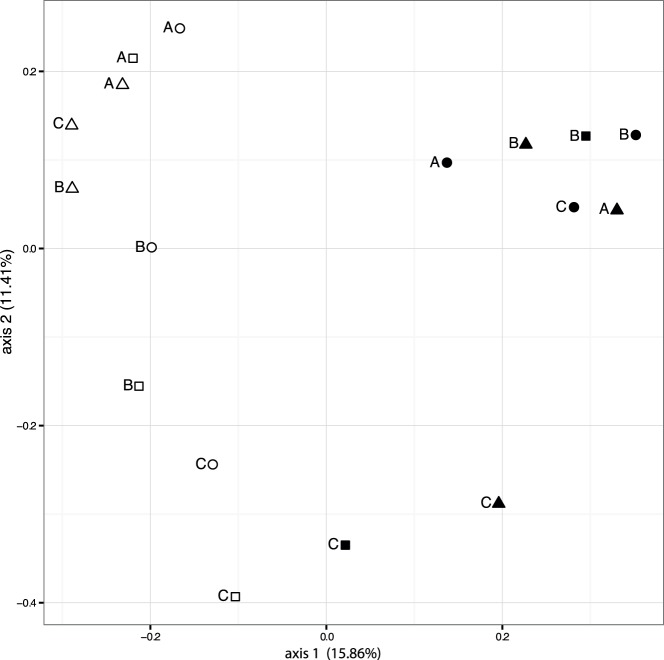
Principal Coordinate Analysis (PCoA) of unweighted UniFrac distances between coral samples.White symbols represent samples from week 1. Black symbols are samples from week 16. Coral colonies are depicted by the letter preceding the symbol (A, B, C). Circles denote cage, triangles denote fertilizer, and squares denote cage & fertilizer treatments. Percentages given represent the amount of variance explained by the corresponding axis.